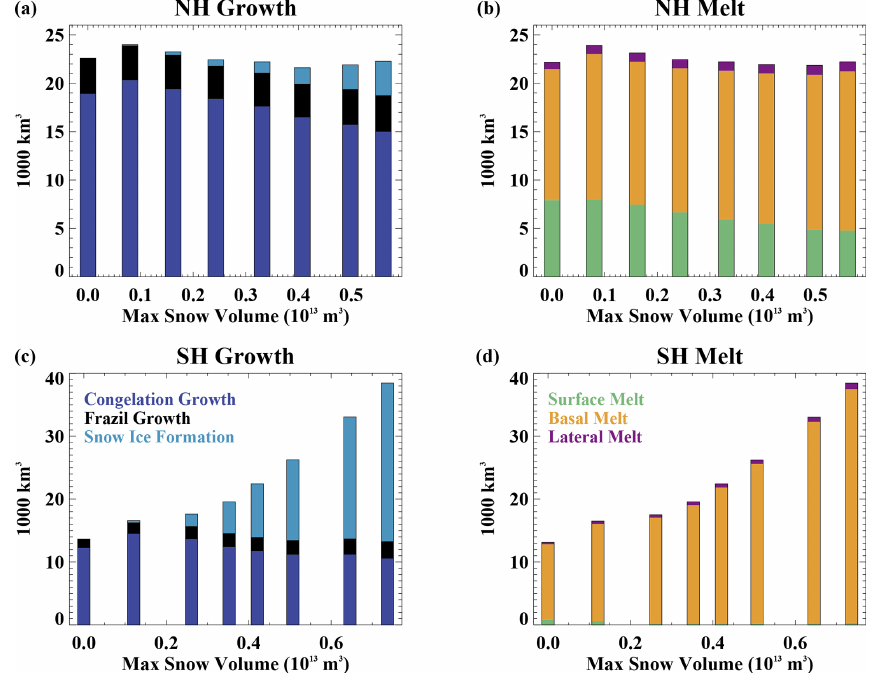
Figure 8. The volume of total annual (a) Northern Hemisphere ice growth, (b) Northern Hemisphere ice melt, (c) Southern Hemisphere ice growth, and (d) Southern Hemisphere ice melt as a function of the maximum snow volume across the